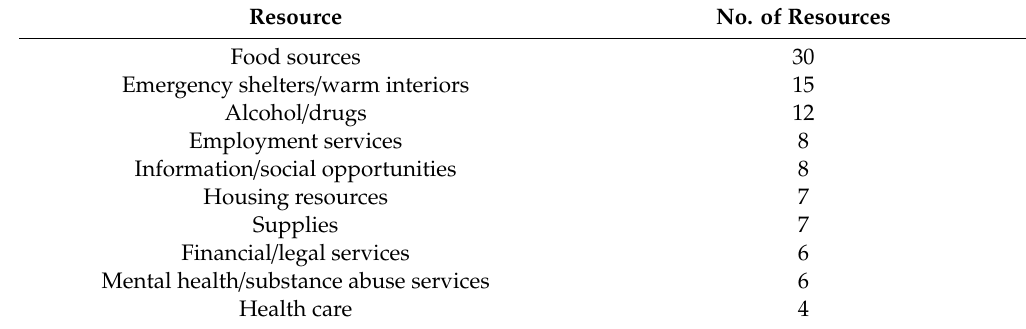
Table 1. Types and amounts of resources available to the homeless population of Newark,